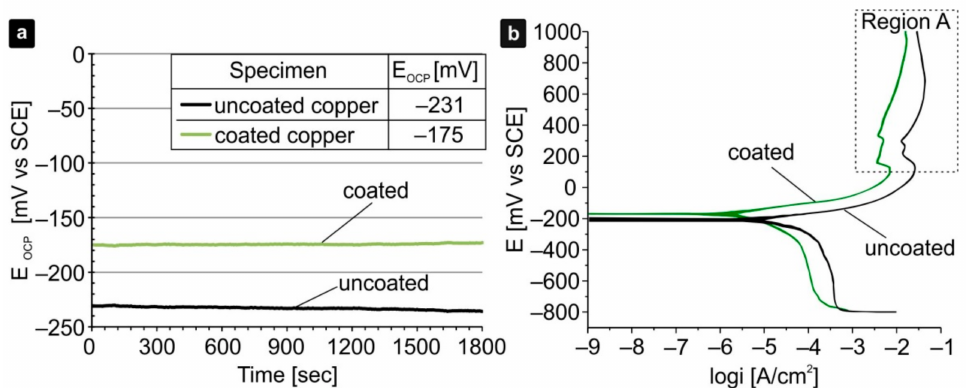
Figure 6. ( a ) Open circuit potential (OCP) and ( b ) polarization curves for silver-coated copper and